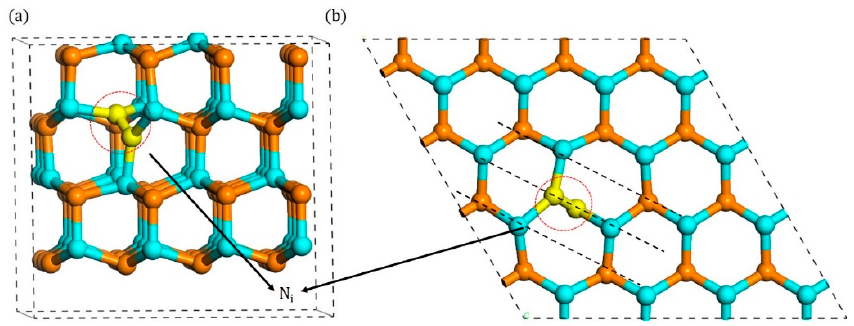
Figure A1. Configurations of B 1 type split interstitial: ( a ) side view and ( b ) top view.